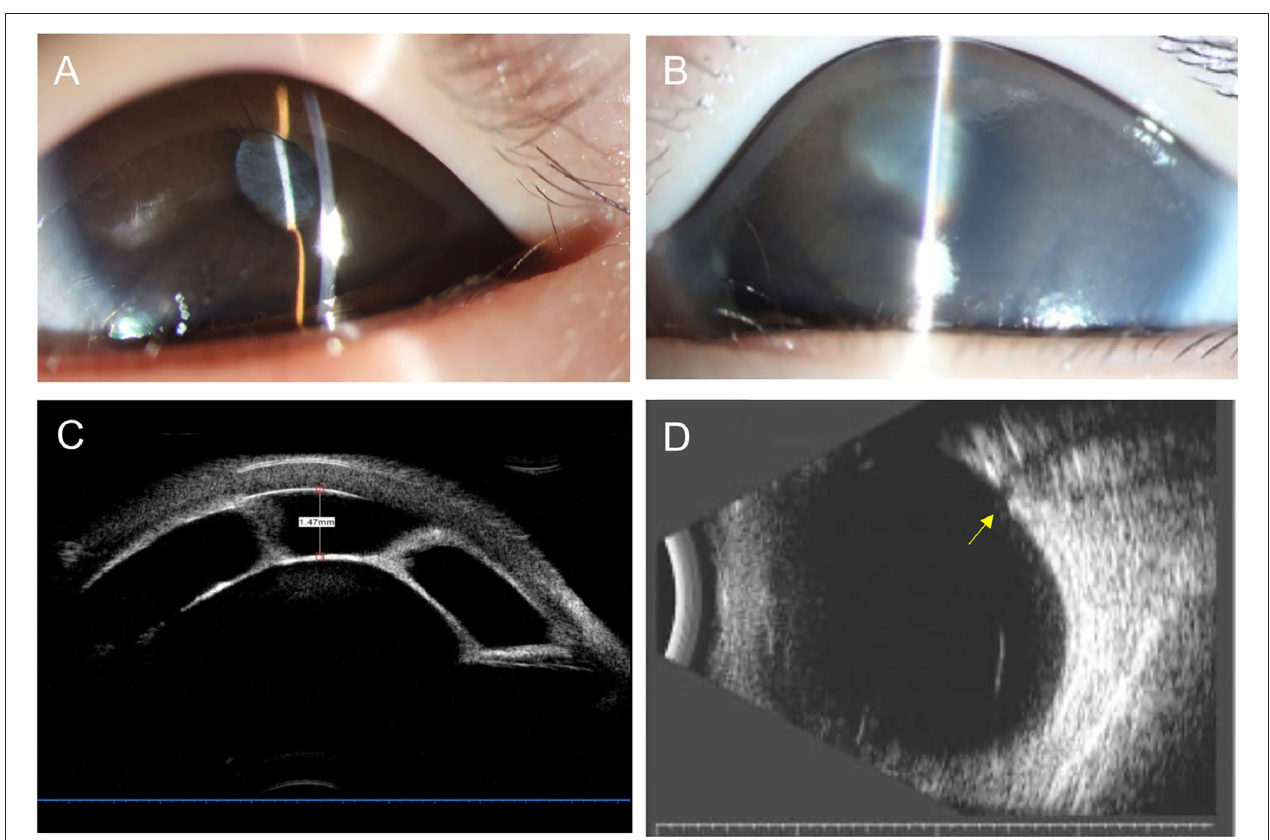
FIGURE 2 | Anterior segment photography, ultrasound biomicroscopy (UBM), and B-scan ultrasonography of a 4-month-old child with congenital fibrous pupillary membrane-induced secondary glaucoma. (A) Anterior segment photograph at 3 months of age showing a clear cornea and normal central and peripheral anterior chamber depth. The pupil is covered by a white vascularized membrane with a few areas of posterior synechiae. (B) Anterior segment photograph at 4 months of age showing moderate corneal edema, iris bombé with the very shallow peripheral anterior chamber, and posterior synechiae covering 360 degrees of the pupil. (C) UBM demonstrates a fibrous membrane adherent to the anterior lens capsule covering the entire pupil leading to iris bombé and peripheral anterior synechiae. Central anterior depth measured 1.47mm. (D) B-scan ultrasound image demonstrates significant cupping of the optic nerve as the yellow arrow